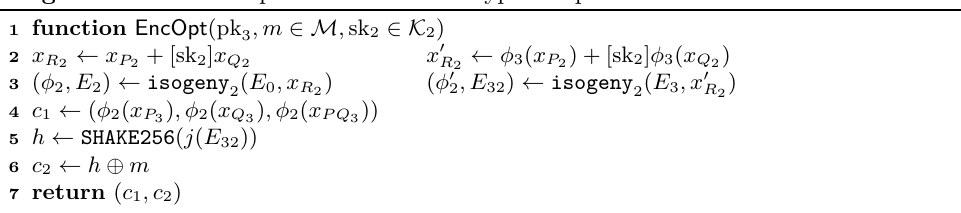
Algorithm 15: The optimized SIPKE encryption